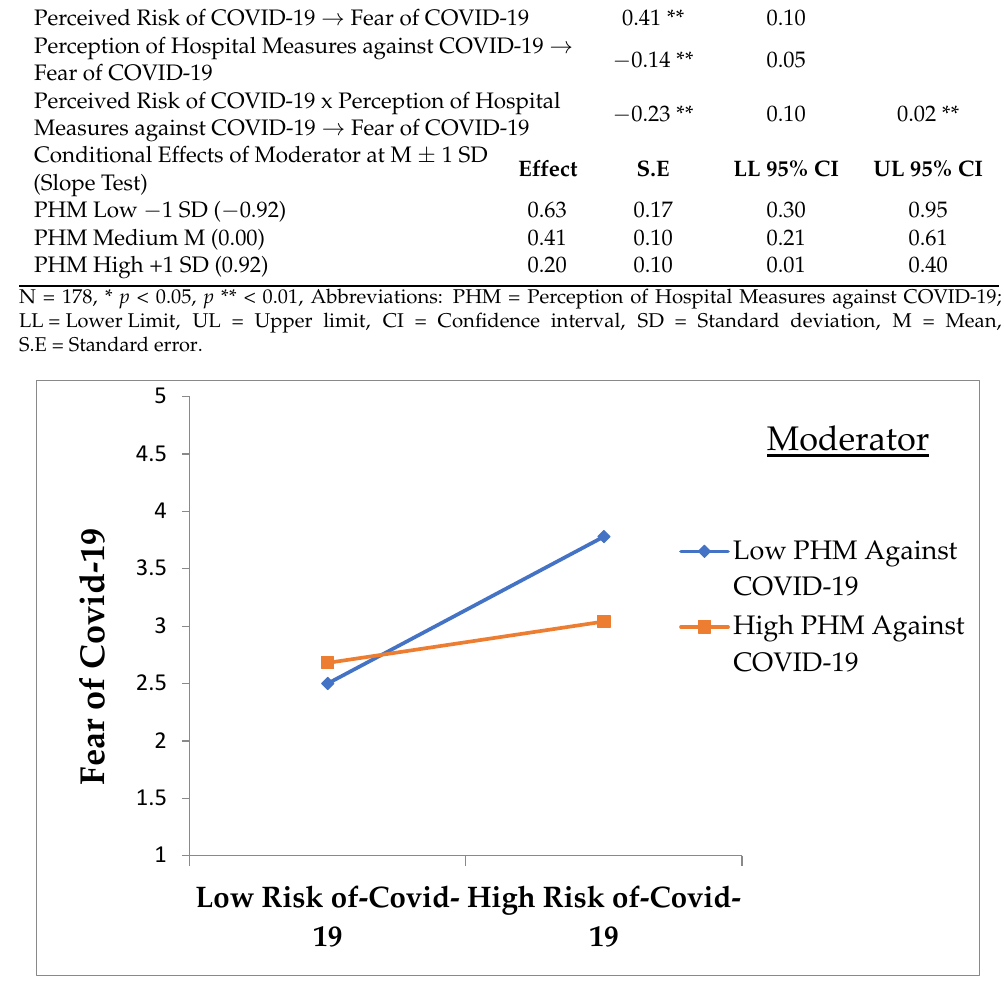
Figure 2. Moderation graph for the buffering effect of perception of hospital measures on the Relationship of perceived risk of COVID-19 and fear COVID-19 of healthcare workers; PHM = Perception of hospital measures.